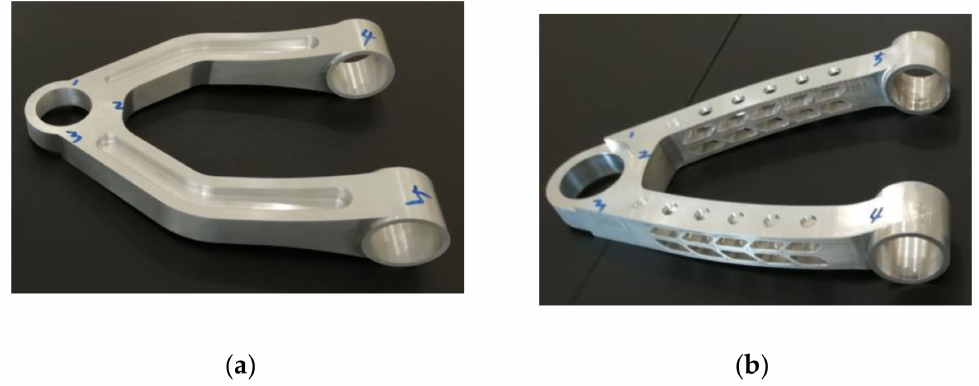
Figure 16. The samples of the control arm: ( a ) initial model (1.01 kg); ( b ) bionic model (0.76 kg).